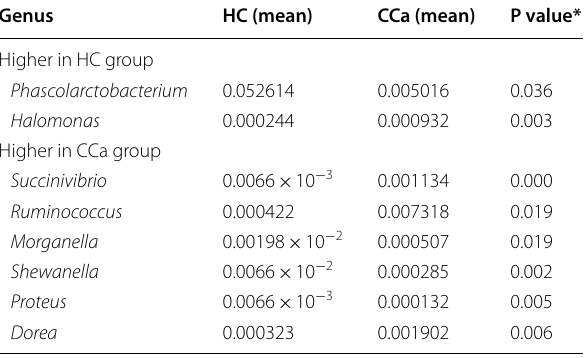
Table 3 Genera differences between patients and